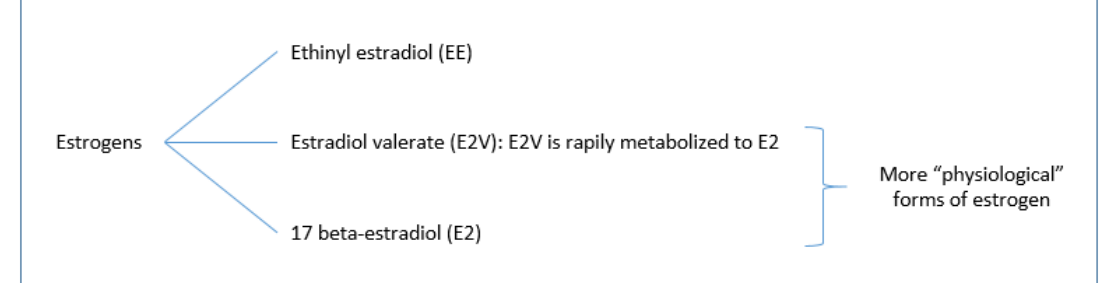
Figure 2. Types of estrogens used in combined oral contraceptives (COCs).